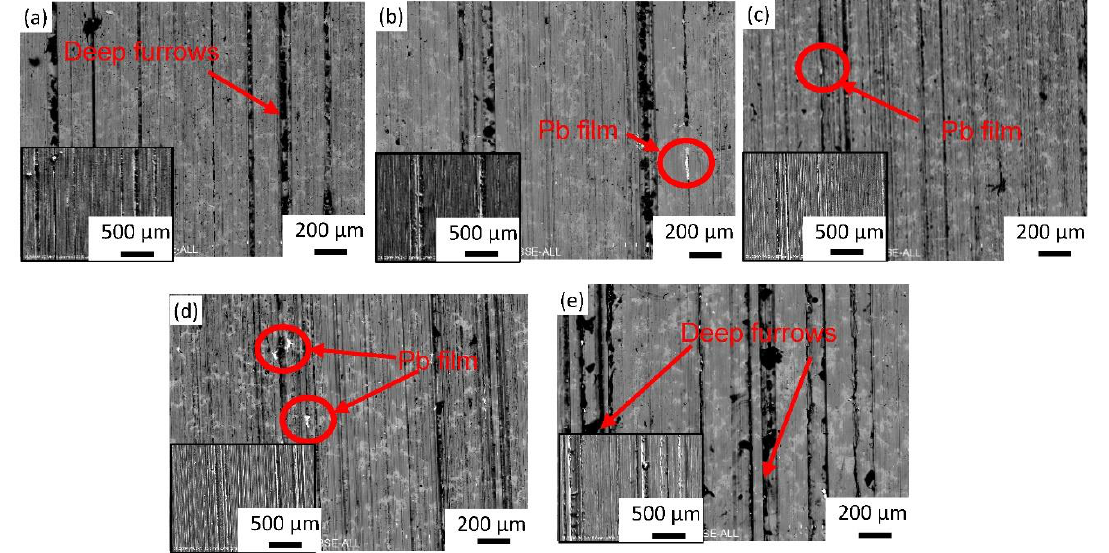
Figure 9. SEM micrograph (BSE mode) showing the surface after the wear test of ( a ) ZCuSn10Pb10, ( b ) ZCuSn10Pb10 + 0.05% Y, ( c ) ZCuSn10Pb10 + 0.1% Y, ( d ) ZCuSn10Pb10 + 0.15% Y and ( e ) ZCuSn10Pb10 + 0.2% Y, with inset (SE mode) indicating the relative depth of the wear track.